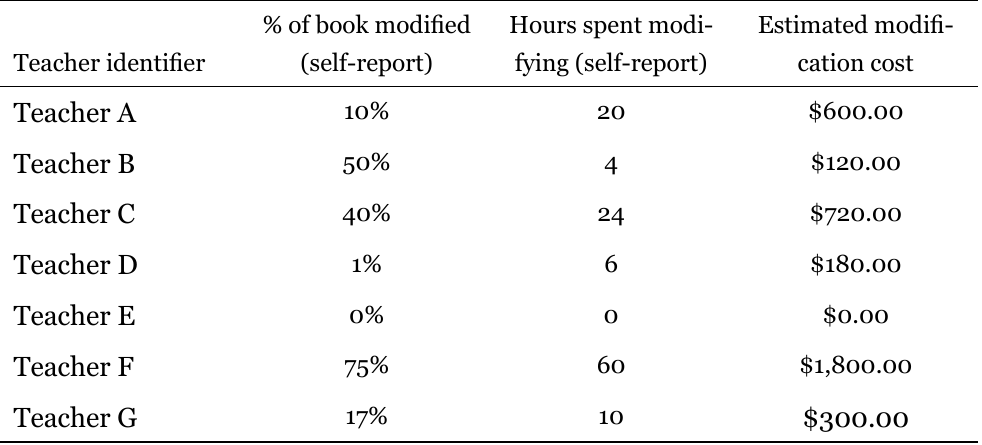
Table 1 Summary of Teacher Efforts to Modify Open Textbooks